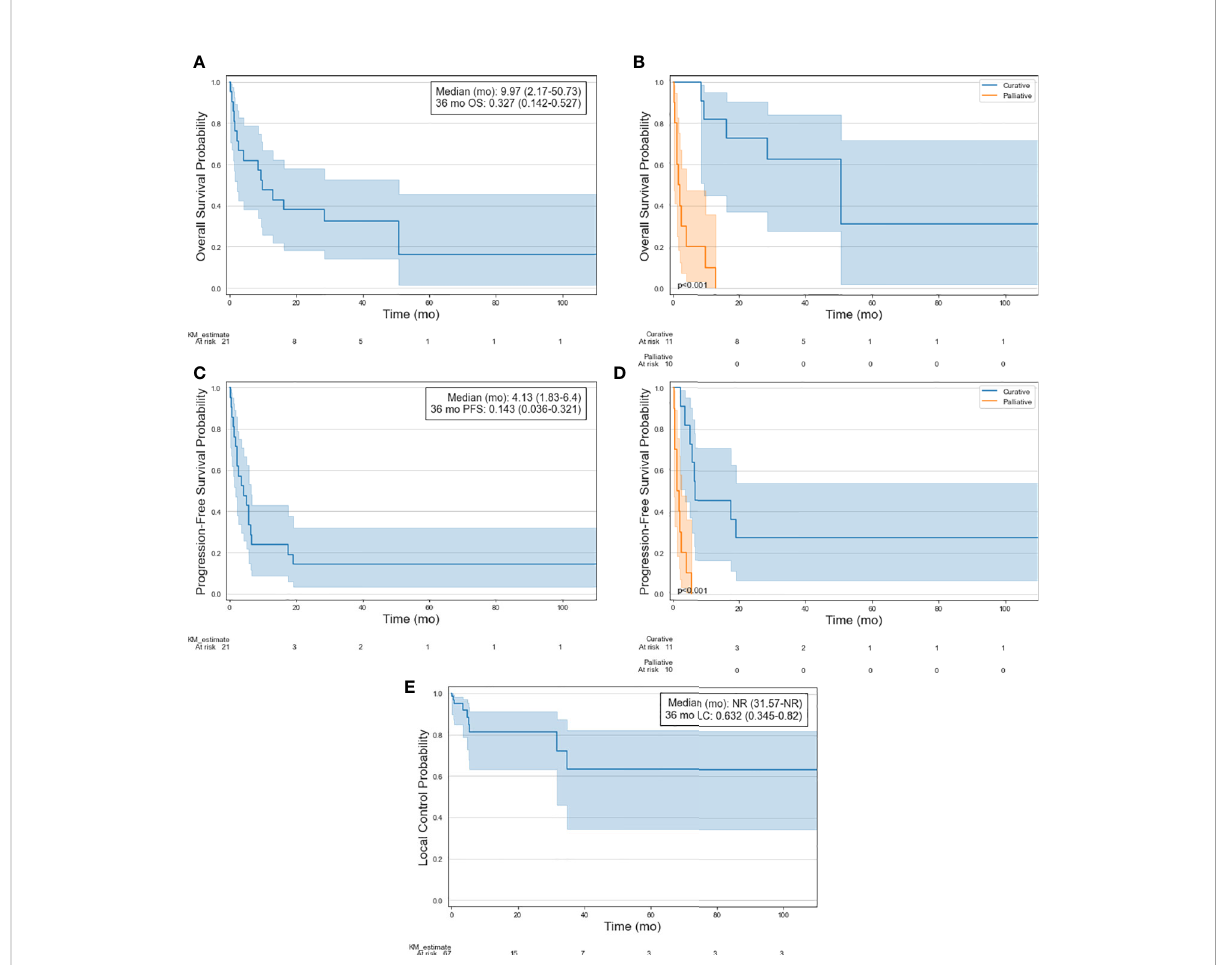
FIGURE 2 Kaplan-Meier curves of selected patient cohort illustrating (A) OS, (B) OS strati fi ed by treatment intent, (C) PFS, (D) PFS strati fi ed by treatment intent, and (E) LC of treated